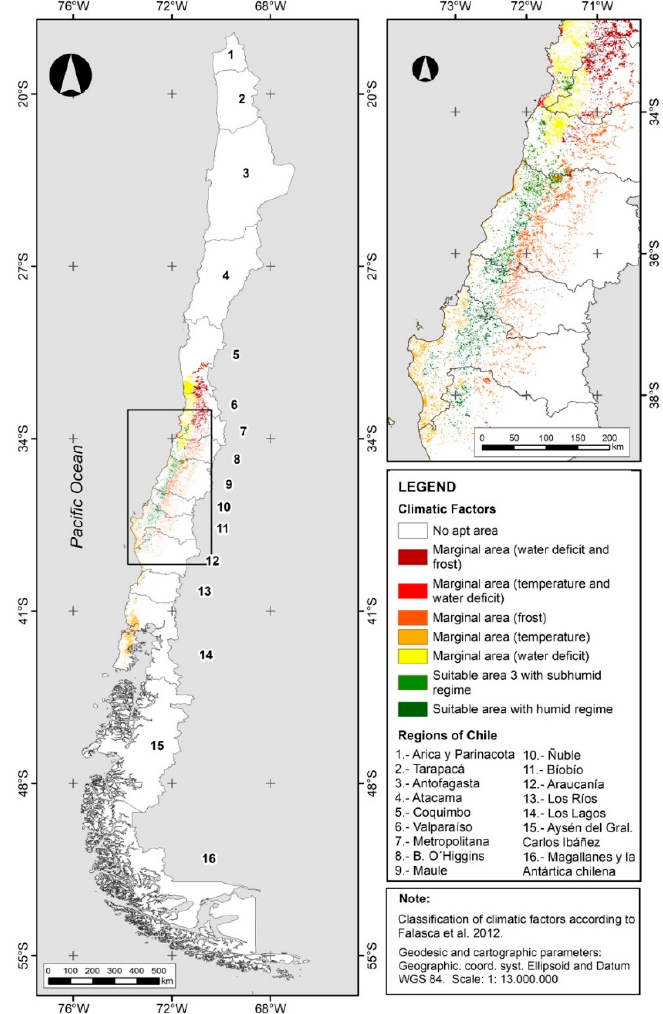
Figure 3. Suitability zoning for castor bean production in Chile according to agro–climatic zonation from the simplistic methodology, but with TNA = 8.0 ° C.